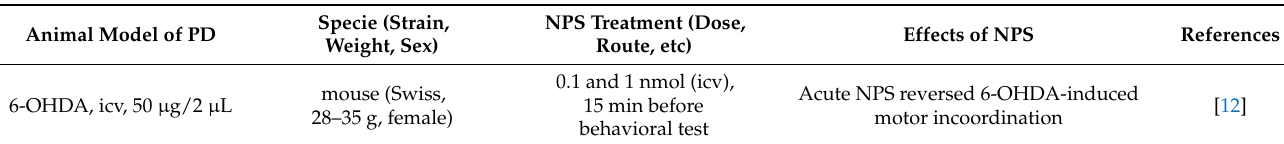
Table 2. Behavioral and neurobiological effects of Neuropeptide S (NPS) treatment in animal models of Parkinson Disease